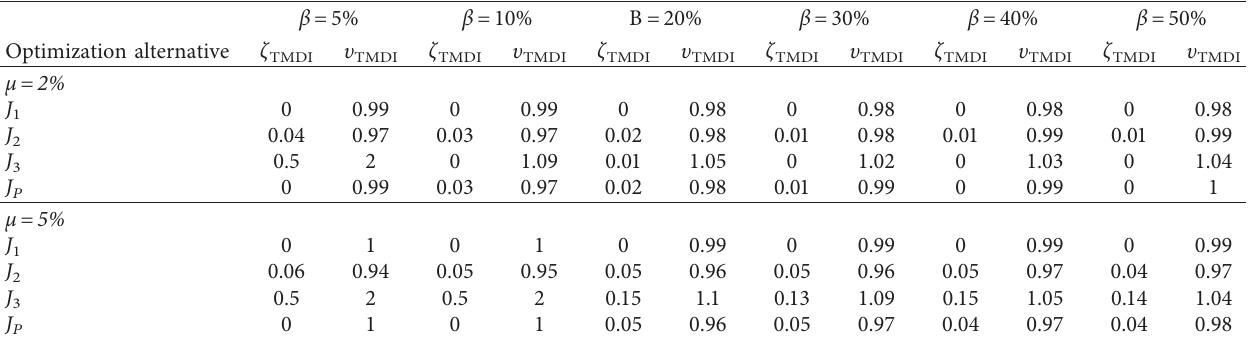
Table 7: TMDI optimization parameters for µ � 0.02 and µ � 0.05 for the structure subjected to the “ El Centro ” record.